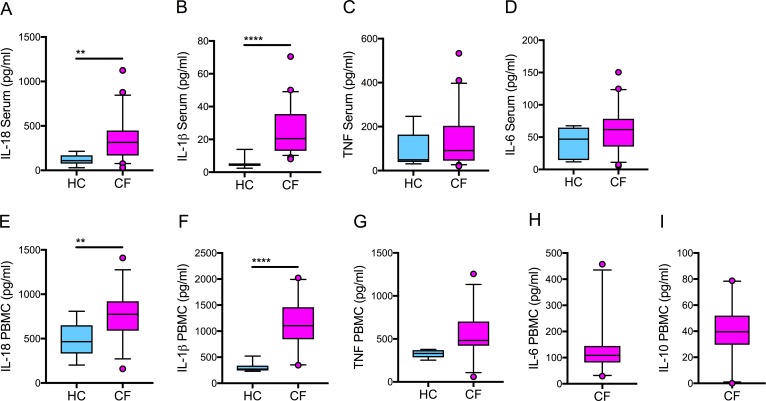
Baseline serum cytokine levels in HC and CF (homozygous Phe508del) and corresponding baseline cytokine levels in NLRP3-stimulated HC and CF immune cells.Serum collected and PBMCs isolated at baseline from patients homozygous for Phe508del CFTR mutations (HC, n = 10; CF, n = 51). ELISA assays were used to detect levels of A, IL-18; B, IL-1β; C, TNF and D, IL-6 in serum. ELISA assays were used to detect levels of E, IL-18; F, IL-1β; G,TNF; H, IL-6; I, IL-10 secretion in PBMCs. PBMCs were stimulated with LPS (10 ng/mL, 4 hr), and ATP (5 mM) for the final 30 min. For PBMC data IL-18, IL-1β (HC n = 11, CF n = 32); TNF (HC n = 6, CF n = 27); IL-6 and IL-10 (CF n = 20) A non-parametric Mann Whitney test was performed. Error bars displayed as 5–95% percentile range with median (p values * = ≤ 0.05, ** = ≤ 0.01, *** = ≤ 0.001 and **** = ≤ 0.0001).